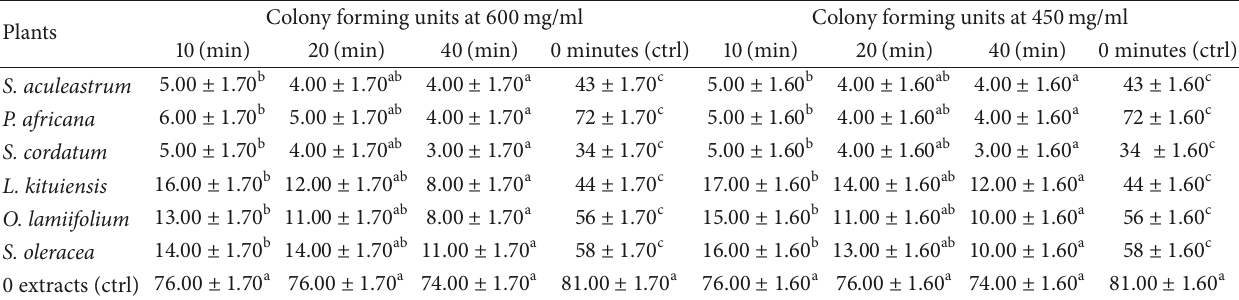
Table 4: Effect of aqueous plant extracts and photosensitization on Aspergillus flavus UONV003. Colony forming units at 600 mg/ml Plants